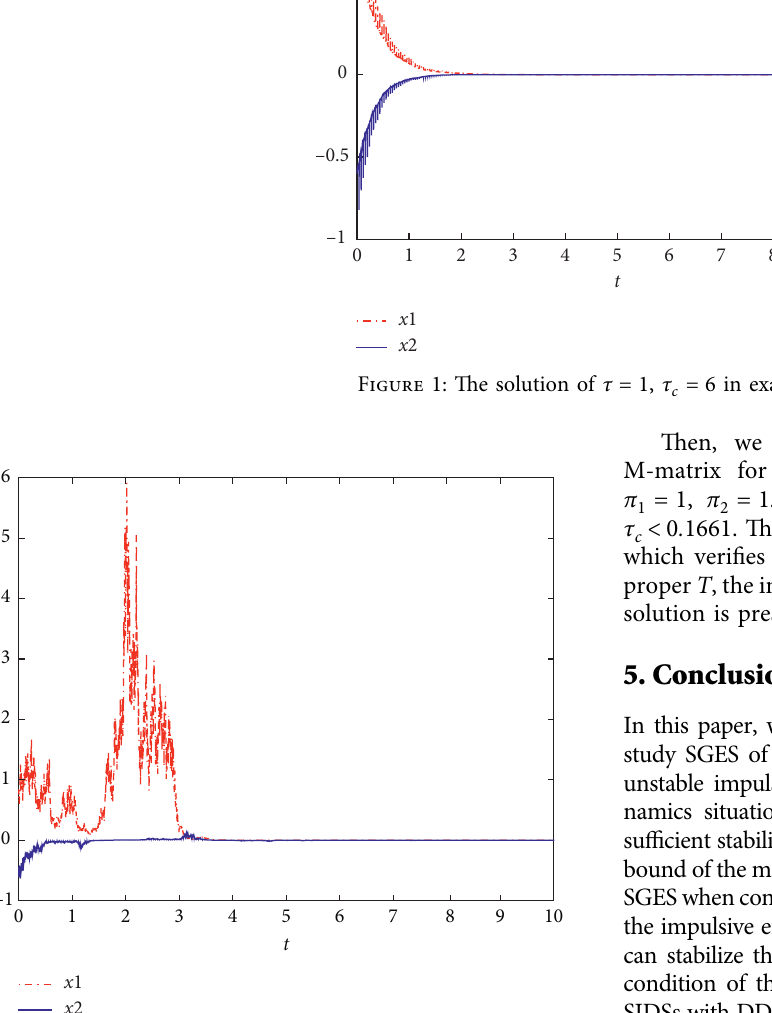
� 0 . 16 in example c